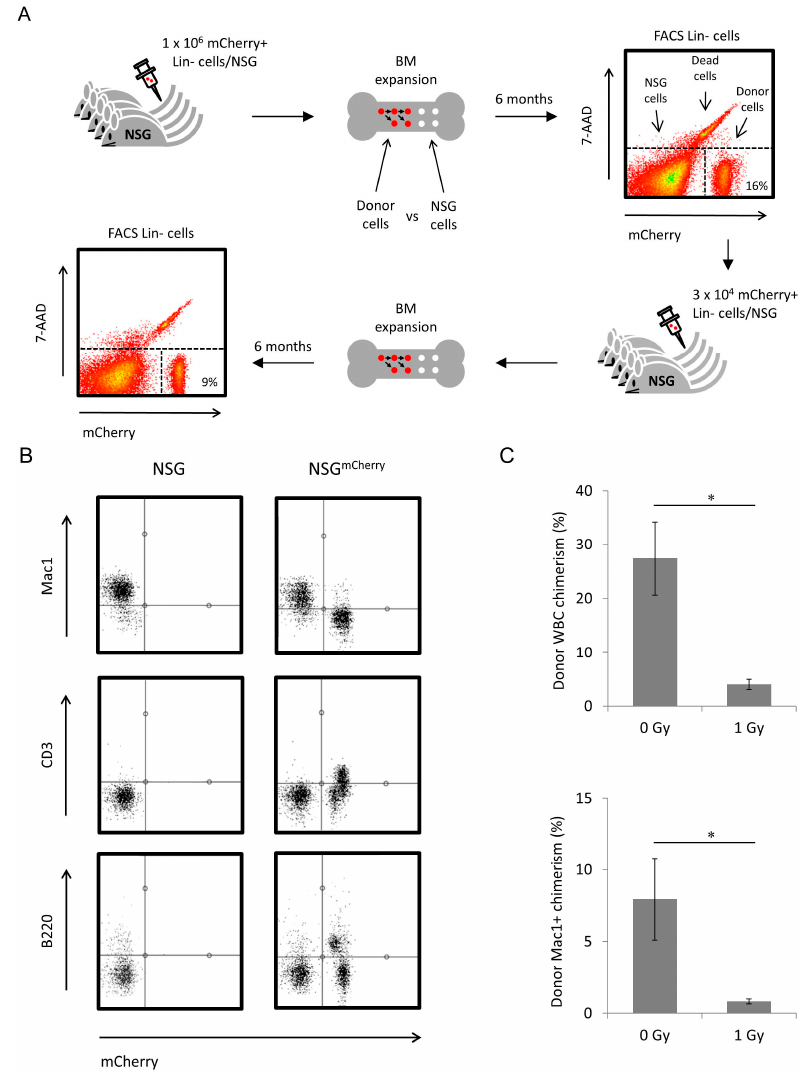
Figure 2. Nonmyeloablated NSG mice are permissive to allogeneic HSC transplantation. ( A )